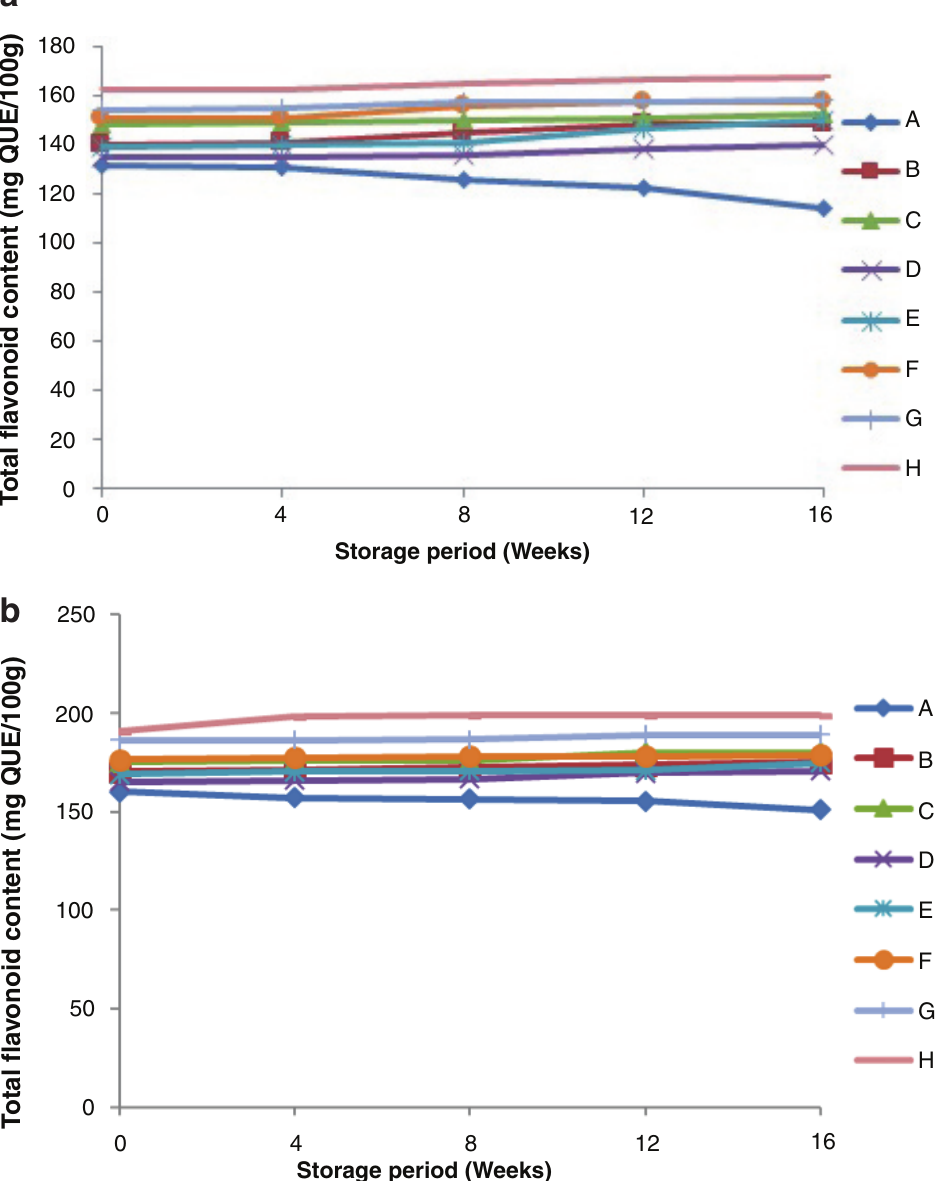
Figure 5. Total Flavonoid Content Ogi flour made with ( a ) maize and ( b ) sorghum with Garlic or Ginger. Sample codes: A: Ogi Flour, B: Ogi Flour + 2% Garlic, C: Ogi Flour + 4% Garlic, D: Ogi Flour + 2% Ginger, E: Ogi Flour + 4% Ginger, F: Ogi Flour +2% Garlic + 2% Ginger, G; Ogi Flour+2% Garlic + 4% Ginger, H: Ogi Flour +4% Garlic + 2% Ginger.